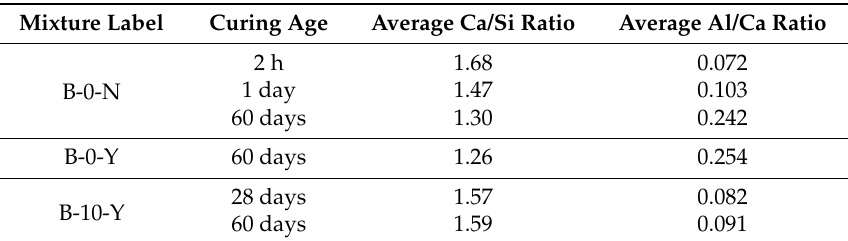
Table 6. The average Ca/Si and Al/Ca ratios of Al-rich C-S-Hs of each mixture. Mixture Figure 11. The microstructures of mixture B-0-N at 2 h: BSE images magnified by ( a ) ×1000 and ( b ) ×3000; EDS spectra of ( c ) point 1 in ( a ); and ( d ) point 2 in ( b ).